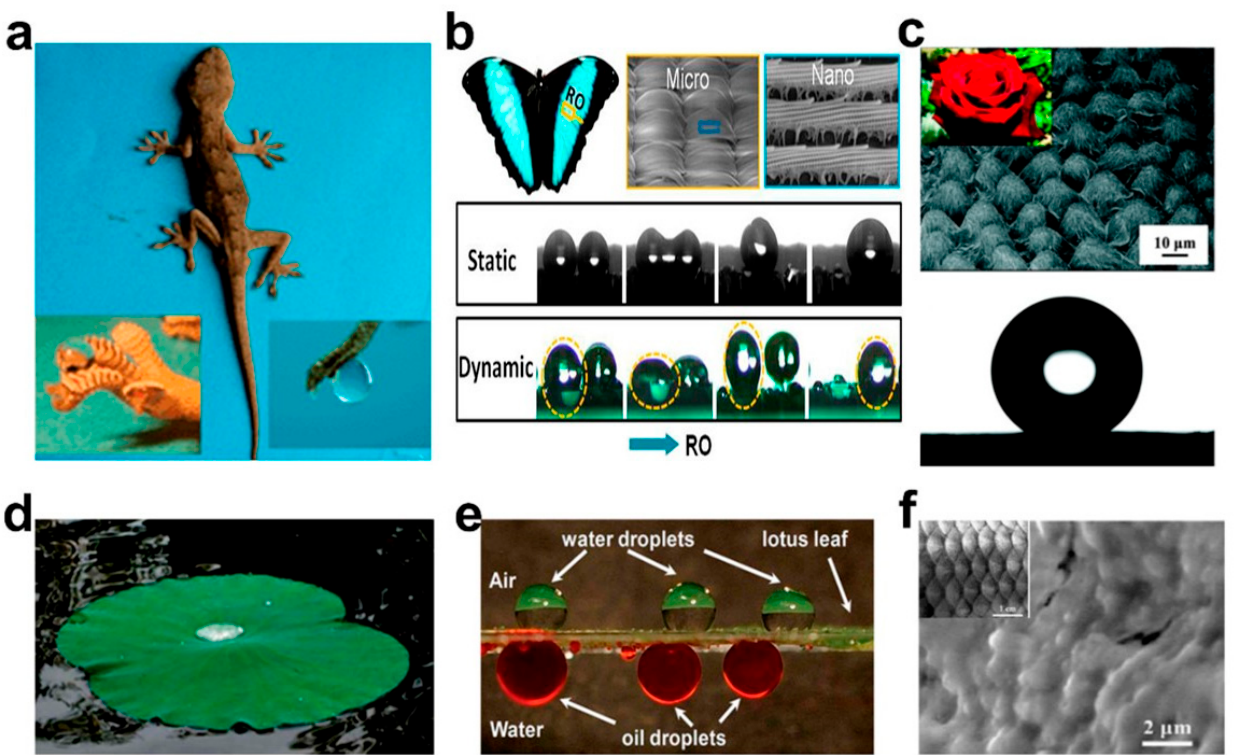
Figure 1. Special wettable surface in nature: ( a ) Photographs of a gecko under anesthesia. ( b ) Photo and SEM images of a Morpho deidamia butterfly, and fog droplet transportation on a static and dynamicbutterfly wing. ( c ) SEM image and digital photograph of a rose petal, and the spherical shape waterdrop on the surface. ( d ) Photograph of the upper surface of lotus leaf. ( e ) Water droplets on the upper surface of the lotus leaf and oil droplets on its lower surface underwater. ( f ) SEM image and optical image of fish scales. Adapted with permission from Ref. [37]. Copyright 2021, American Chemical Society.